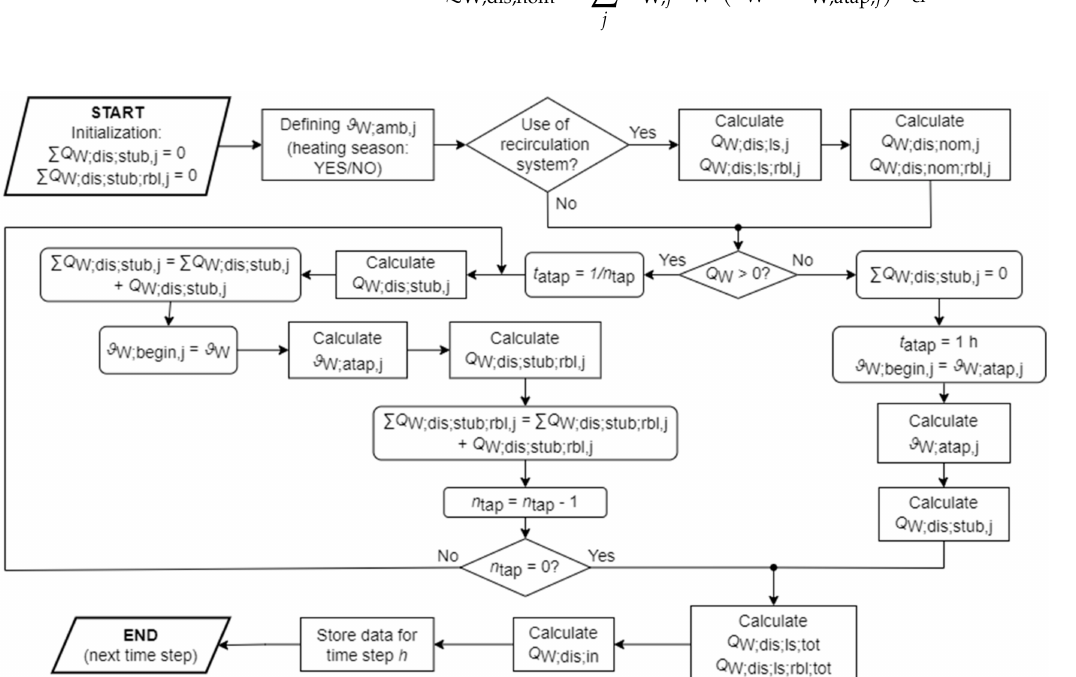
Figure 3. Calculation flowchart of DHW distribution subsystem heat losses in observed time step, when n tap is known, according to the proposed method based on EN